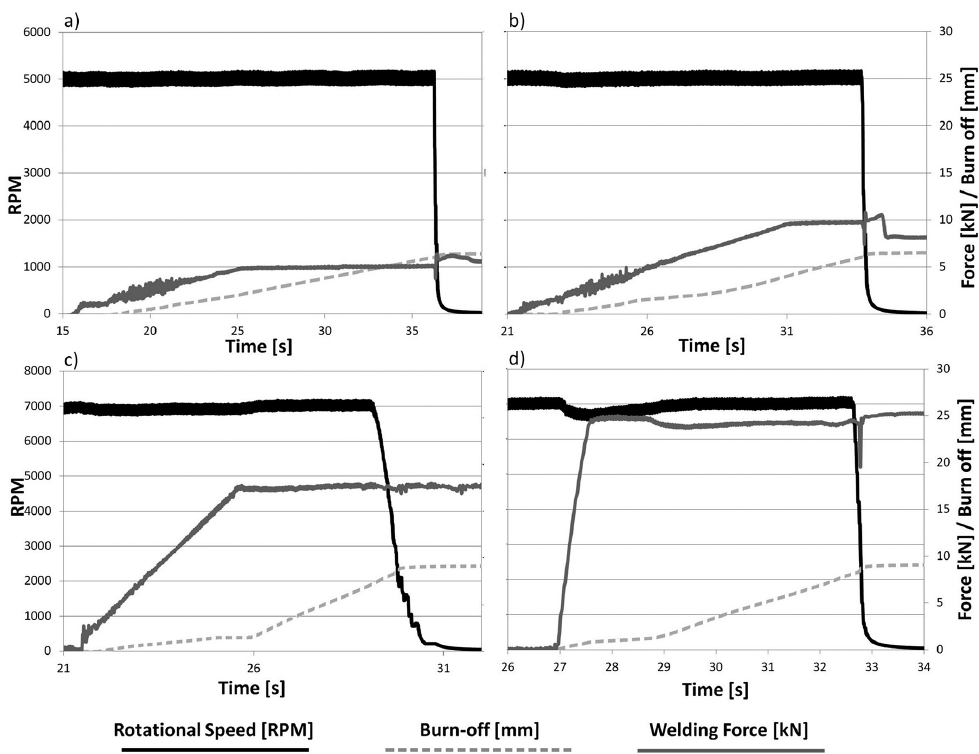
Figure 4: Acquisition data in different welding conditions. a) Speed 5000 RPM, Burn-off 6 mm, Force 5 kN. b) Speed 5000 RPM, Burn- off 6 mm, Force 10 kN. c) Speed 7000 RPM, Burn-off 9 mm, Force 18 kN. d) Speed 7000 RPM, Burn-off 9 mm, Force 25 kN.